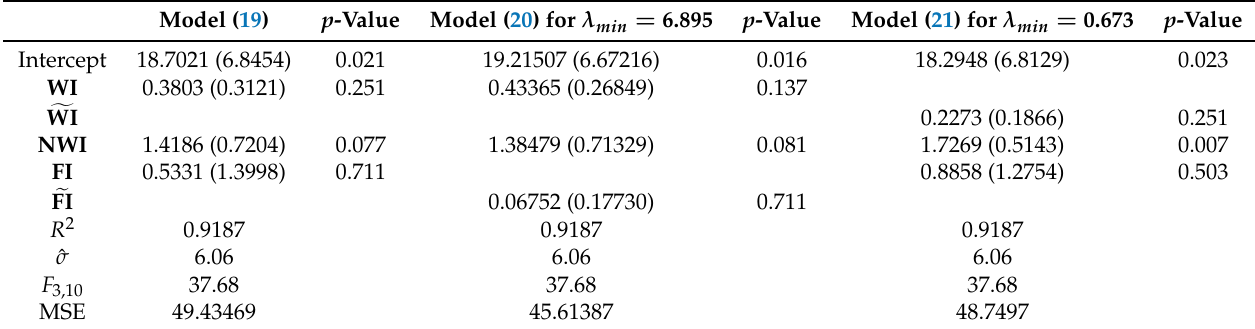
Table 9. Estimation of the original and raised models: Standard deviation is inside the parentheses, R 2 is the coefficient of determination, F 3,10 is the experimental value of the joint significance contrast, and ˆ σ 2 is the variance estimate of the random